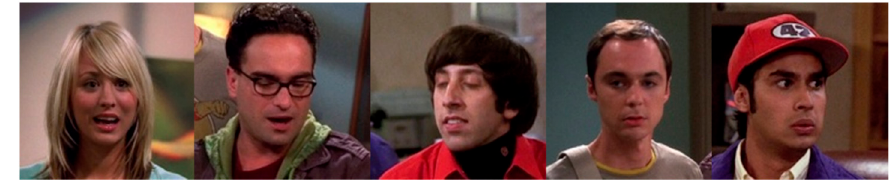
Figure 3. Samples from ICT-BBT [52].